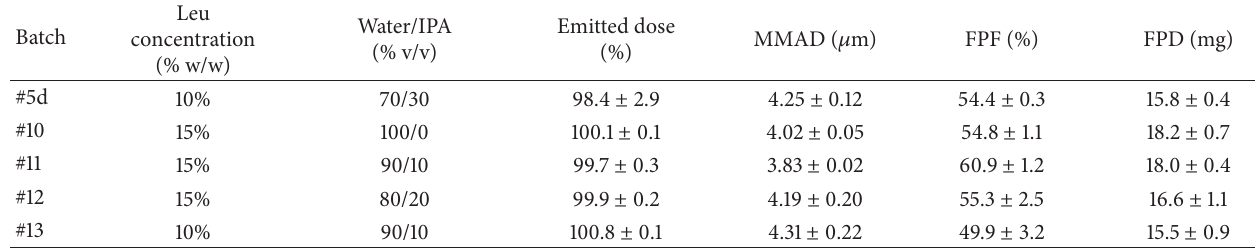
Figure 4: SEM pictures of powders obtained from (a) #14 (6%w/v, water/IPA 100/0v/v, 10% leu), (b) #13 (6%w/v, water/IPA 90/10v/v, 10%leu), (c) #10 (6% w/v, water/IPA 100/10v/v, 15%leu), and (d) #11 (6% w/v, water/IPA 90/10 v/v, 15% leu). Table 4: Aerodynamic properties of Klys/leu powders sprayed through a surfactant treated nozzle (70 ∘ C, 4 𝜇 m nozzle, and 6% w/v feed) after ACI experiments: emitted dose (ED), mass median aerodynamic diameter (MMAD), fine particles fraction (FPF), and fine particle dose